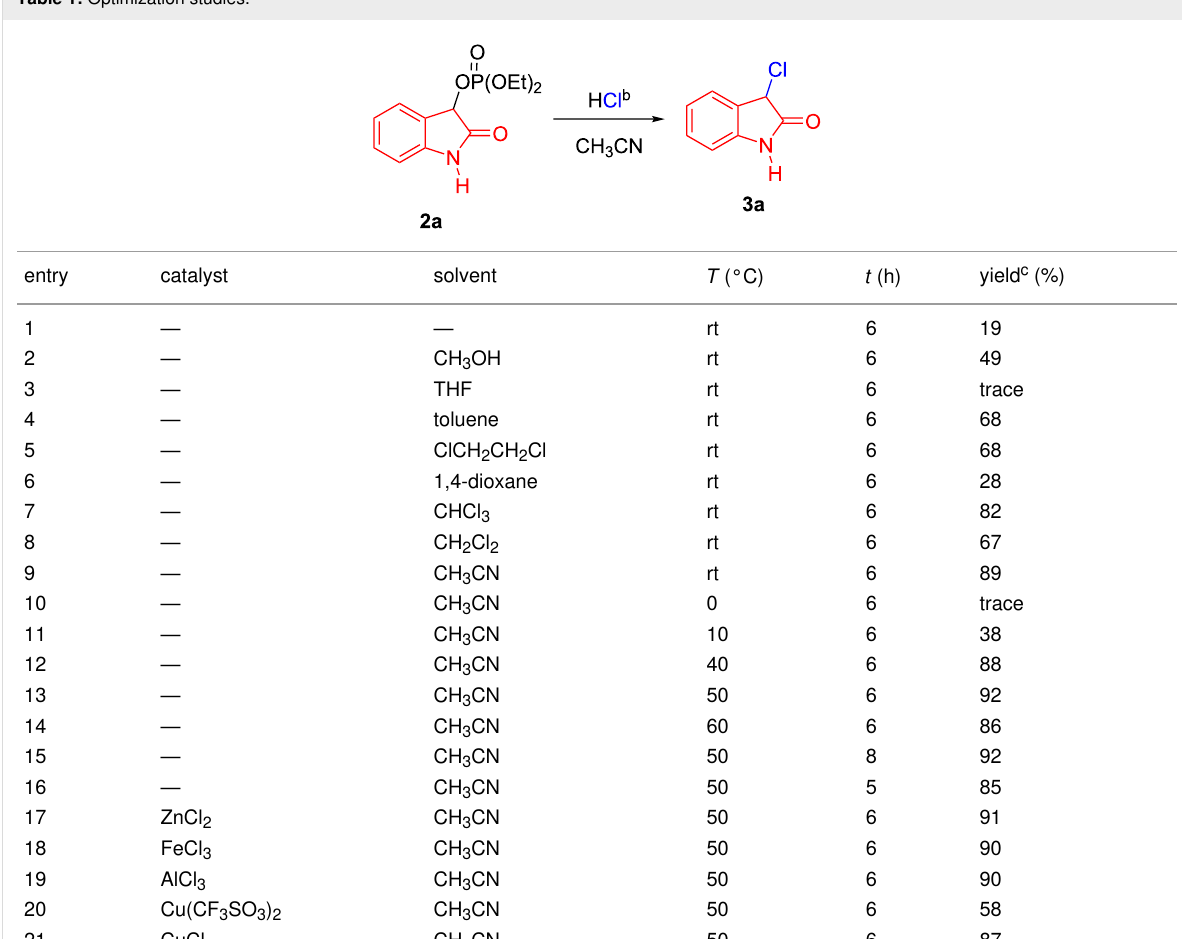
Table 1: Optimization studies.